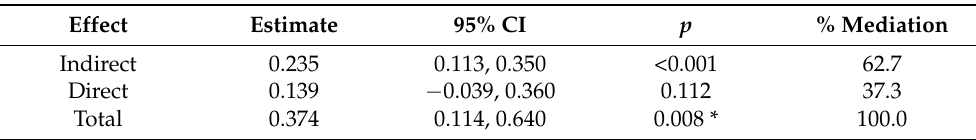
Table 7. Mediation analysis exploring the effect of triangular/lambda pattern on 30-day mortality mediated by left ventricular